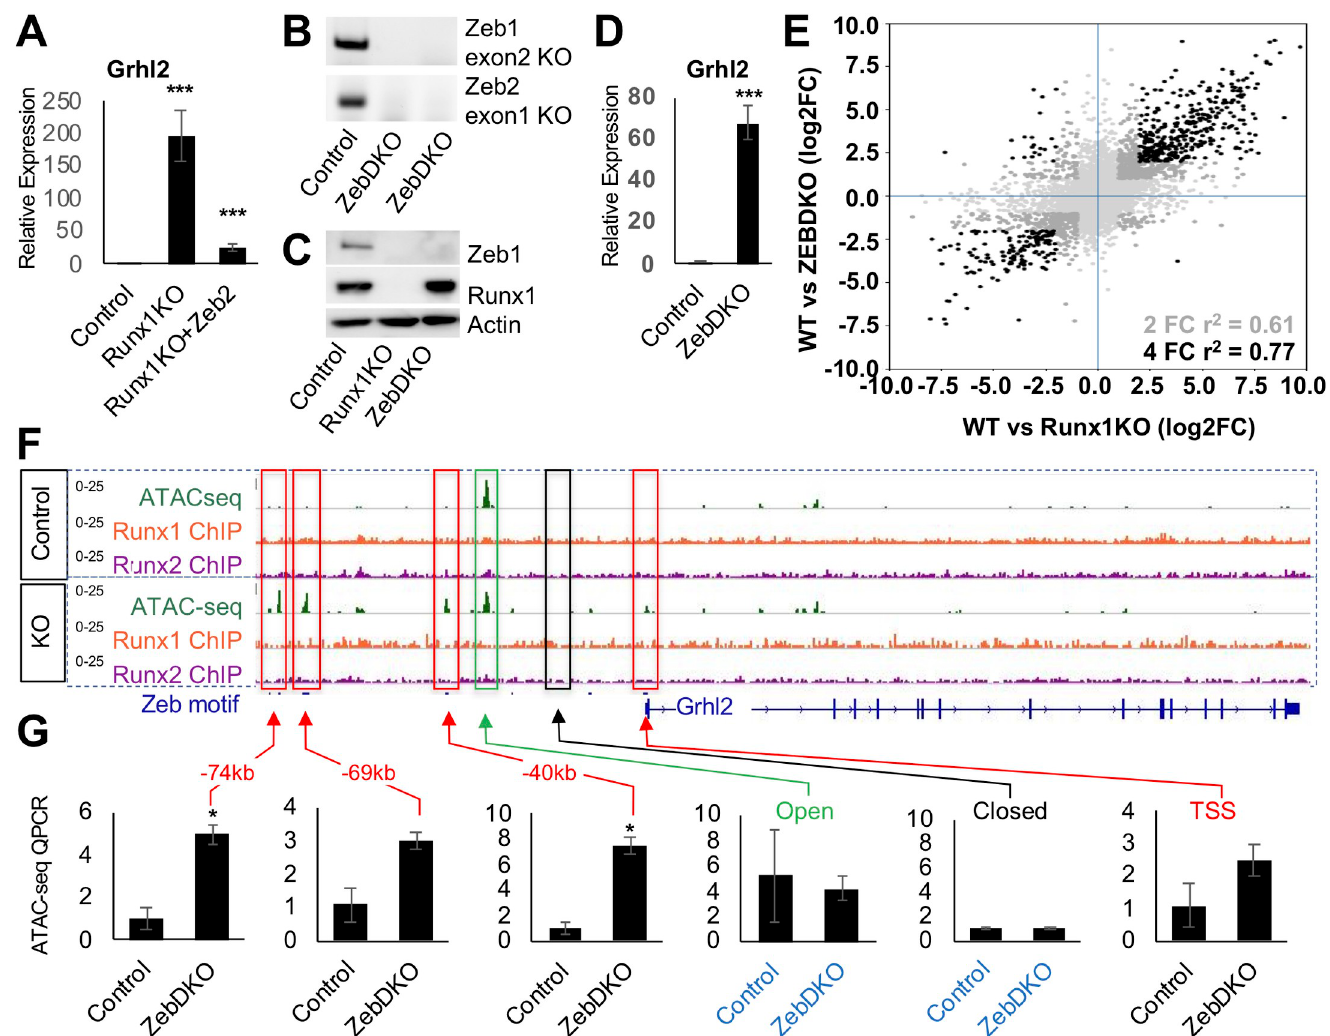
Fig 5. Loss of Zeb Proteins Recapitulates the Opening of Chromatin and Transcriptional Induction of Runx1KO. A) RT-qPCR confirmation of the upregulation of Grhl2 in Runx1KO cells, which is suppressed by transient transfection of Zeb2. B) Genotyping PCR showing deletions of Zeb1 exon2 and Zeb2 exon1 in ZebDKO clones. C) Western blot confirmation of loss of Zeb1 proteins in ZebDKO cells. D) RT-qPCR showing that ZebDKO cells have a dramatic increase in Grhl2 expression. E) Scatter plot showing the correlation of gene expression changes in Runx1KO and ZebDKO cells compared to control mK4 cells (light gray all genes, dark gray genes with 2 fold change in expression in both and black are genes with over 4 fold change in expression in both). F) Grhl2 loci displaying ATAC-seq regions that are specifically open in Runx1KO cells (outlined in red) that contain predicted Zeb binding sites. G) Graphs of ATAC QPCR data showing that the regions near Grhl2 that were opened in Runx1KO cells similarly become significantly more open in ZebDKO cells while control open and closed regions are similar between control and ZebDKO cells. ( � = p-value < 0.05, �� = p < 0.005; ��� = p-value < 0.0005).